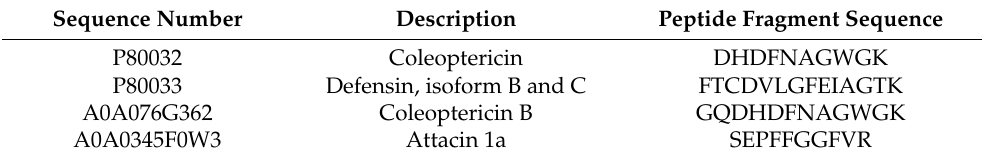
Table 1. Antibacterial protein component in Z. morio antimicrobial